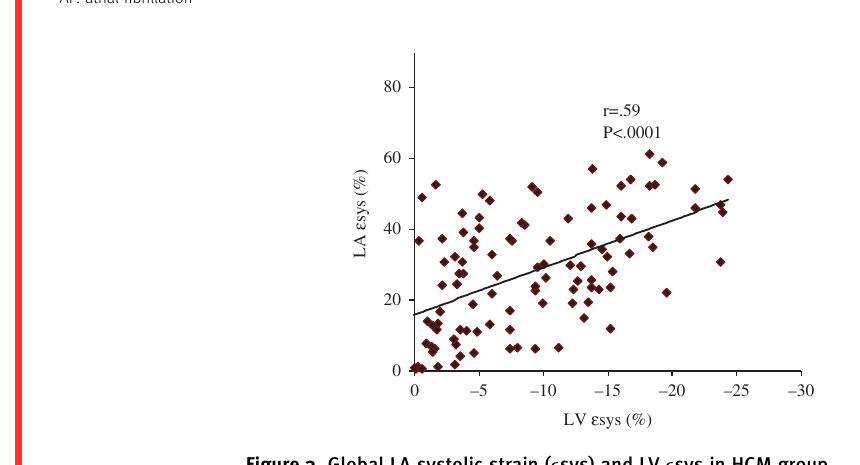
Figure 3. Global LA systolic strain ( e sys) and LV e sys in HCM group.